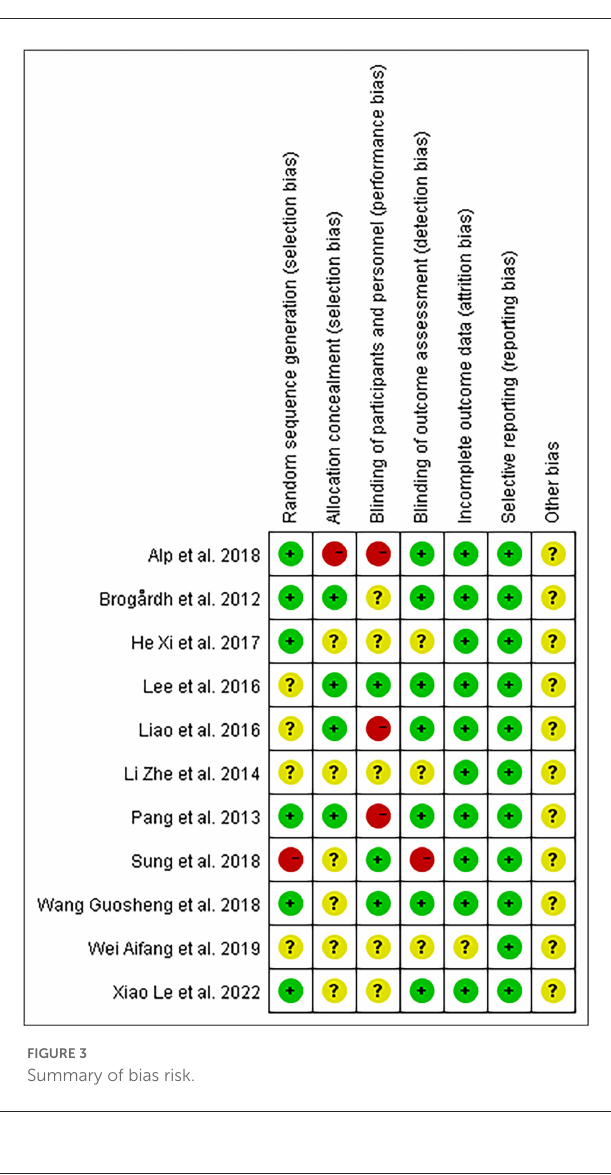
FIGURE3 Summary of bias risk.